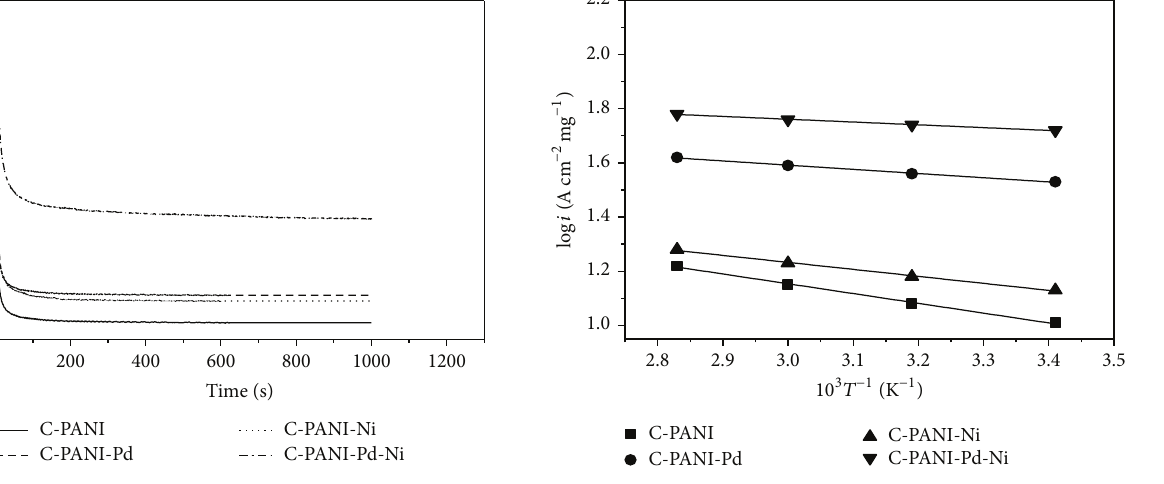
Figure 5: Chronoamperograms for methanol oxidation on different electrodes in 0.5 M H 2 SO 4 solution containing 1.0 M methanol at 0.2 V.